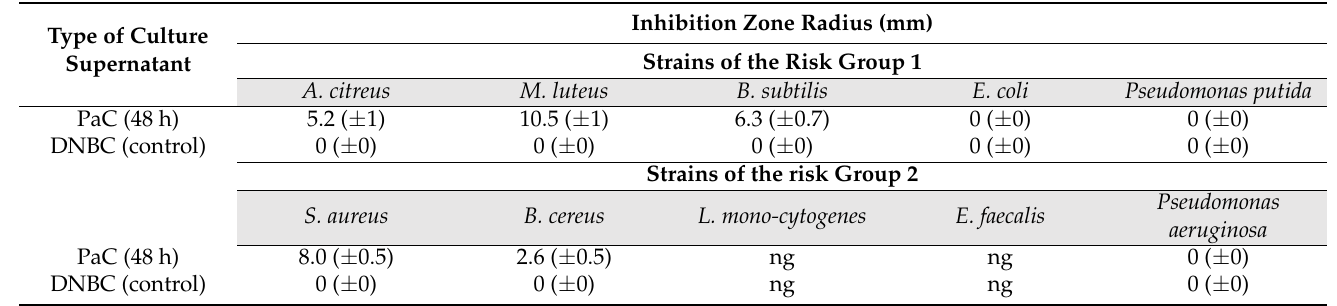
Table 6. Antimicrobial activity of culture supernatants of P. apiarius SBUG 1947 against different test strains of risk groups 1 and